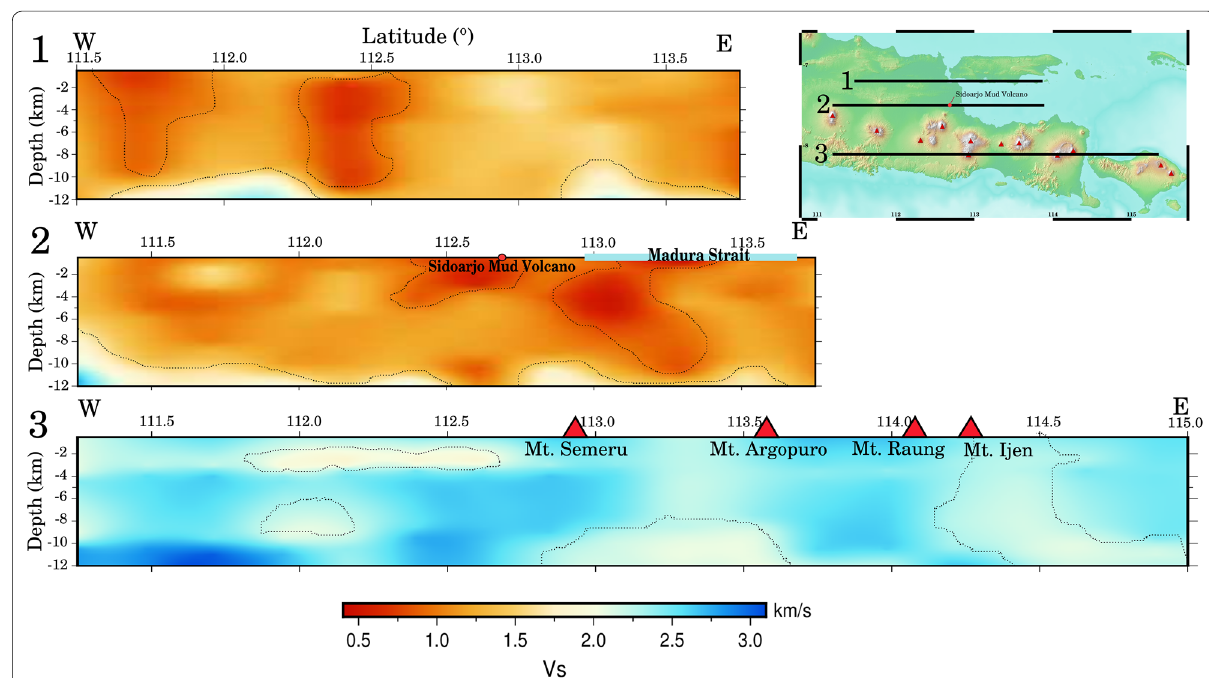
Fig. 9 Vertical profiles ( 1 , 2 , 3 ) of shear wave velocity resulting from Neighborhood Algorithm inversion of ANT dispersion curves along the three lines shown in the inset